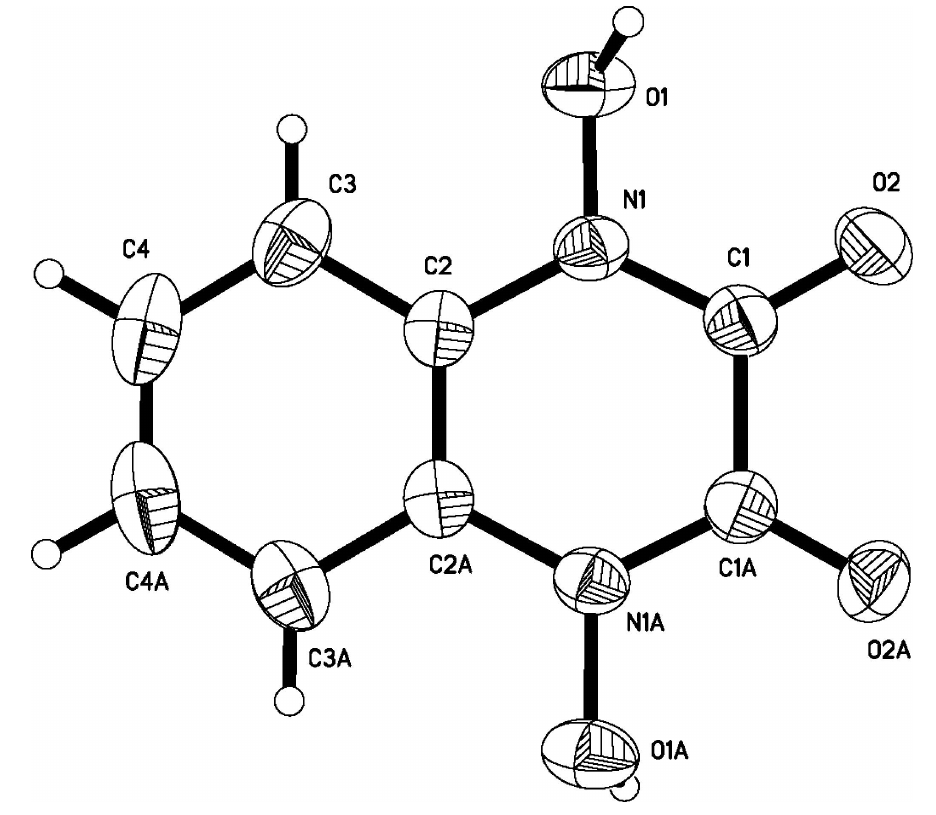
Figure 2 The molecular structure of the title molecule, with the atom-numbering scheme. Displacement ellipsoids are drawn at the 50% probability